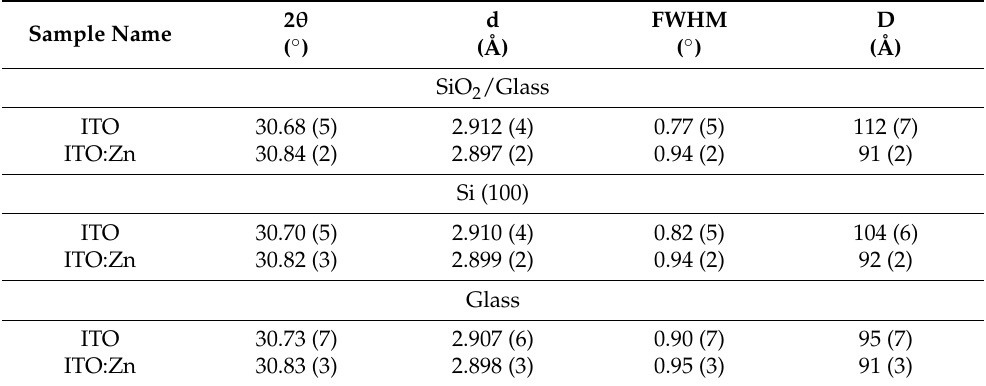
Table 2. Structural parameters and crystallite size.